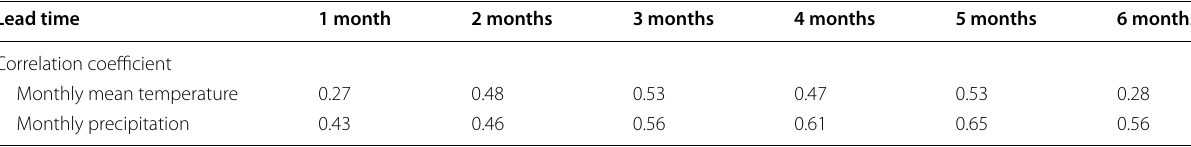
obtained by the general method and modified method were relatively similar. Therefore, it is more advanta- geous to apply the general model to predict the average monthly temperature data and the modified model to predict the monthly precipitation data.